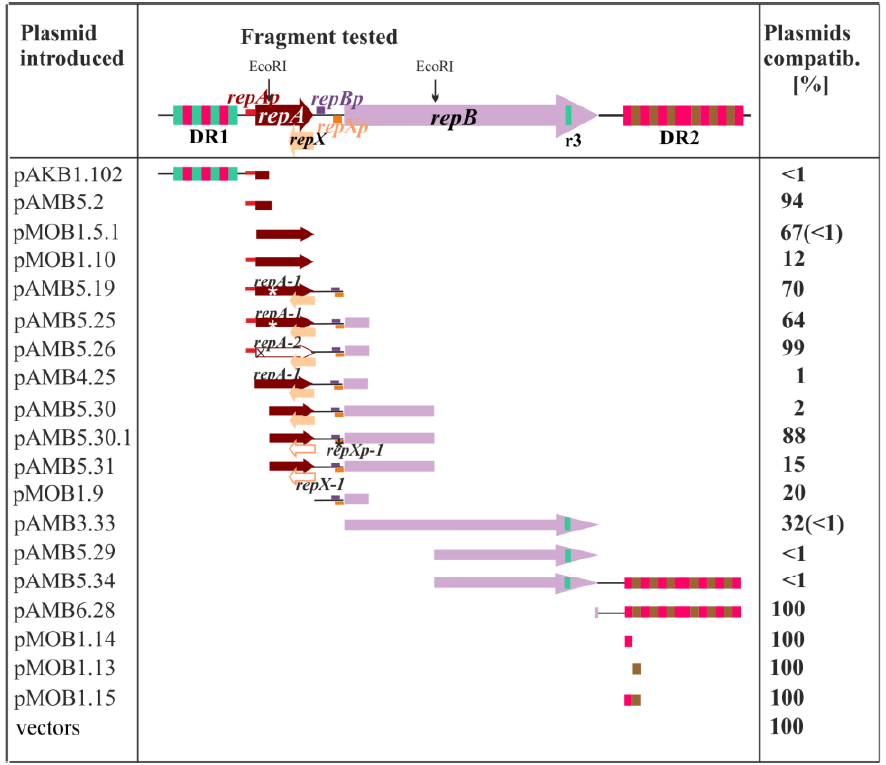
Figure 3. Incompatibility test. The indicated fragments were cloned into high copy number plasmids: pUC18 or pGBT30 and introduced into E. coli DH5α (miniRA3 -1) strain. The transformants were selected either on Pen plates (incoming plasmid) or Pen and Kan plates (both resident and incoming plasmids). Plasmid compatibility is expressed as the percentage of cells carrying both plasmids versus the number of transformants after selection for the incoming plasmid. In the case of pMOB1.5.1 ( tacp-repA ) and pAMB3.33 ( tacp-repB ), the transformants were selected without or with 0.5 mM IPTG, the tacp inducer. The values in the brackets correspond to the level of the co-existence of both plasmids under conditions of RepA or RepB protein overproduction.